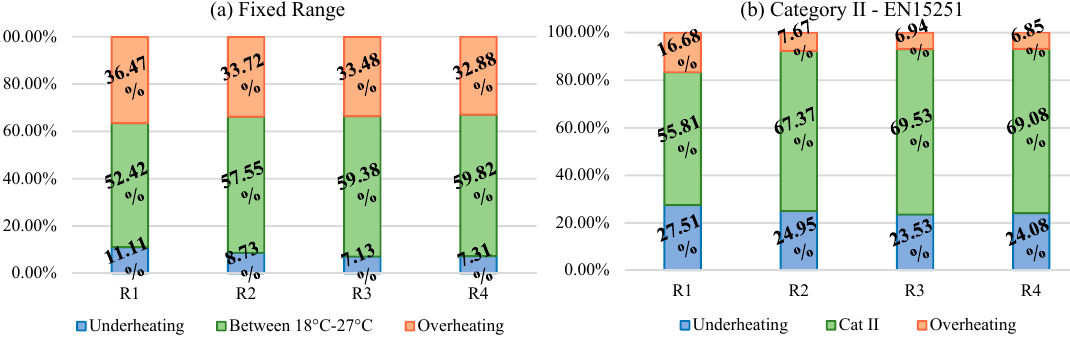
Figure 5. Comfort rates according to the fixed range ( a ) and the EN15251 for Category II ( b ) for different roof configurations.